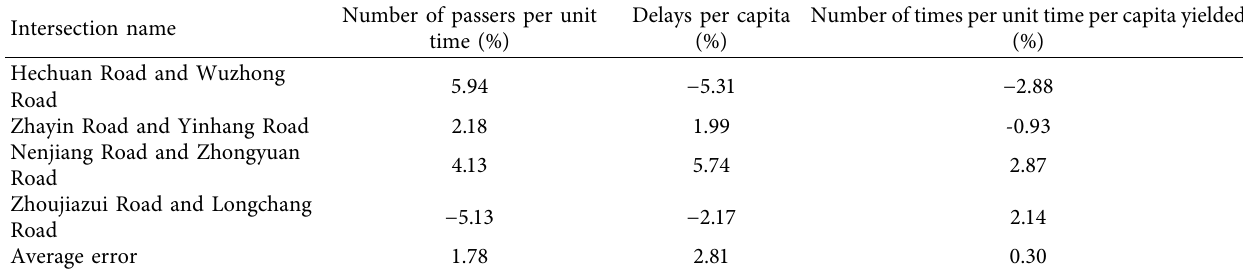
Table 4: Comparison of calculation value of model with the actual observed value.